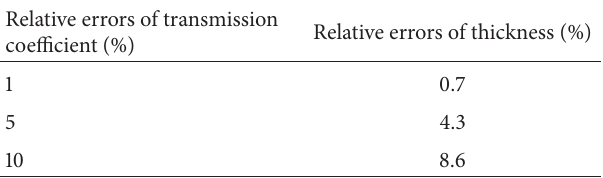
Table 10: Influence of transmission coefficient’s error on the rad- ome’s thickness.